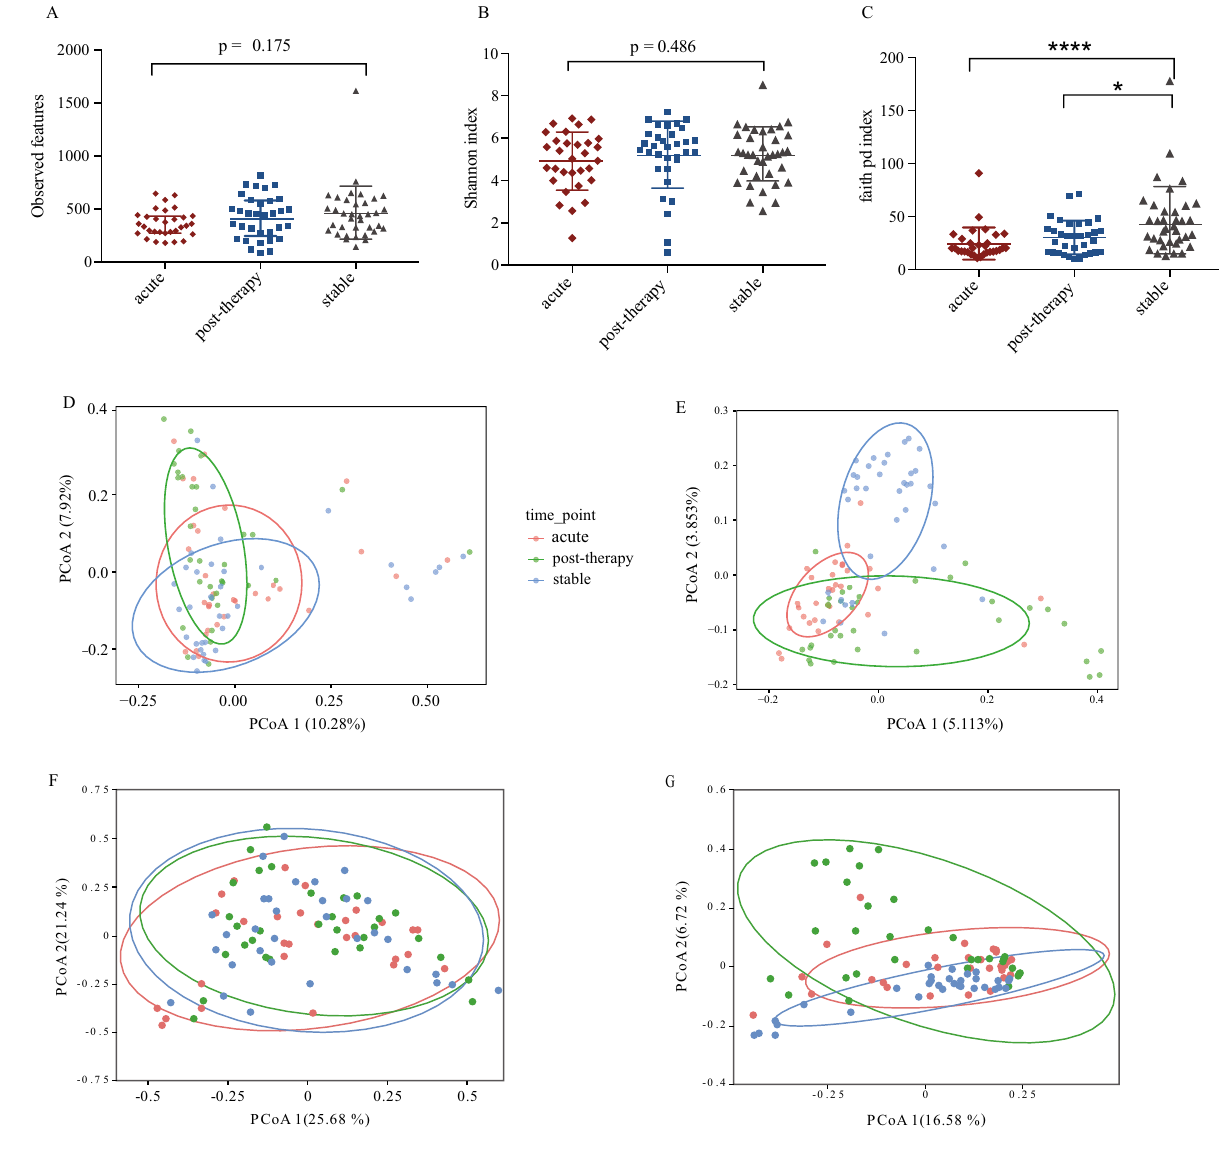
Figure 1. Diversity of respiratory microbial community in patients with different disease states. ( A – C ) The number of OTU observed, Shannon index and Faith PD index among the three groups. ( D – G ) The PCoA plots based on Bray Curtis, Jaccard distance, Weighted-Unifrac, and Unweighted-Unifrac distance. OUT operational taxonomic unit, PCoA principal coordinate analysis, Faith PD faith’s phylogenetic diversity. * p < 0.05, **** p <